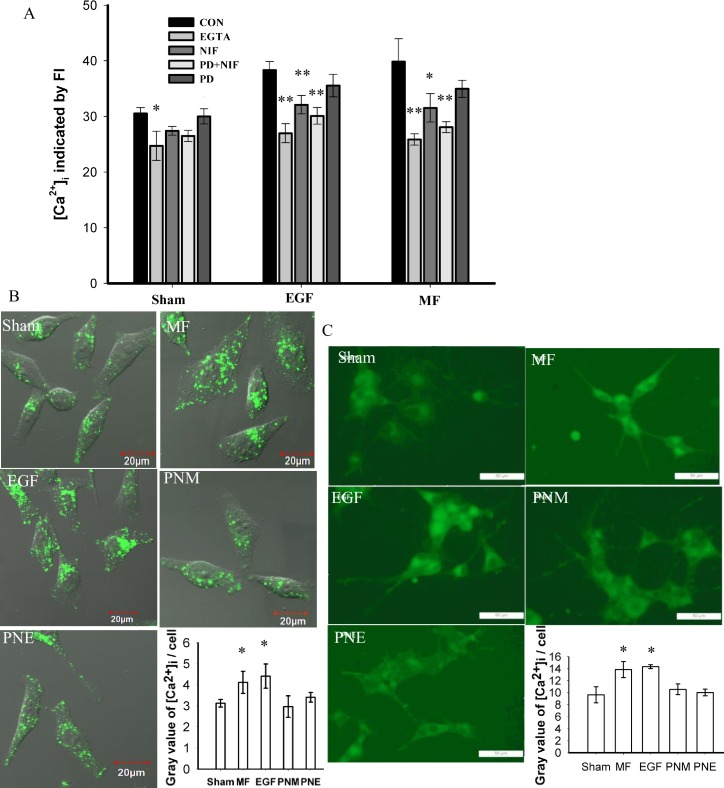
MF induced [Ca2+]i elevation.A: [Ca2+]i measured in FL cells by flow cytometric analyses. CON: control; EGTA: pretreated with as low as 1 μM [Ca2+]o by EGTA chelation; NIF: pretreated with 0.02 mM NIF for 40 min; PD: pretreated with 1 μM PD for 2 h; PD+NIF: pretreated with 1 μM PD for 2 h and 0.02 mM NIF for 40 min; Sham: sham exposed for 30 min; MF: exposed to 0.4 mT 50 Hz MF for 30 min; EGF: treated with 100 nM EGF for 30 min. ** and *: P-value < 0.01 and < 0.05, respectively, when compared with the corresponding CON in the same group by Student’s t-test. B and C: [Ca2+]i imaged by Fluo-4AM in FL (B) and PC12 (C) cells; the groups were treated as described in Fig 1 and in Materials and Methods. The horizontal line represents 20 μm in B and 50 μm in C; for each cell line, gray value of [Ca2+]i in at least 100 cells of each condition was quantified in the bar chart, * and **: p-value < 0.05 and < 0.01, respectively, when compared with CON of the same group. Details of the analyzed cell number and repeat times were listed in S1 Table.